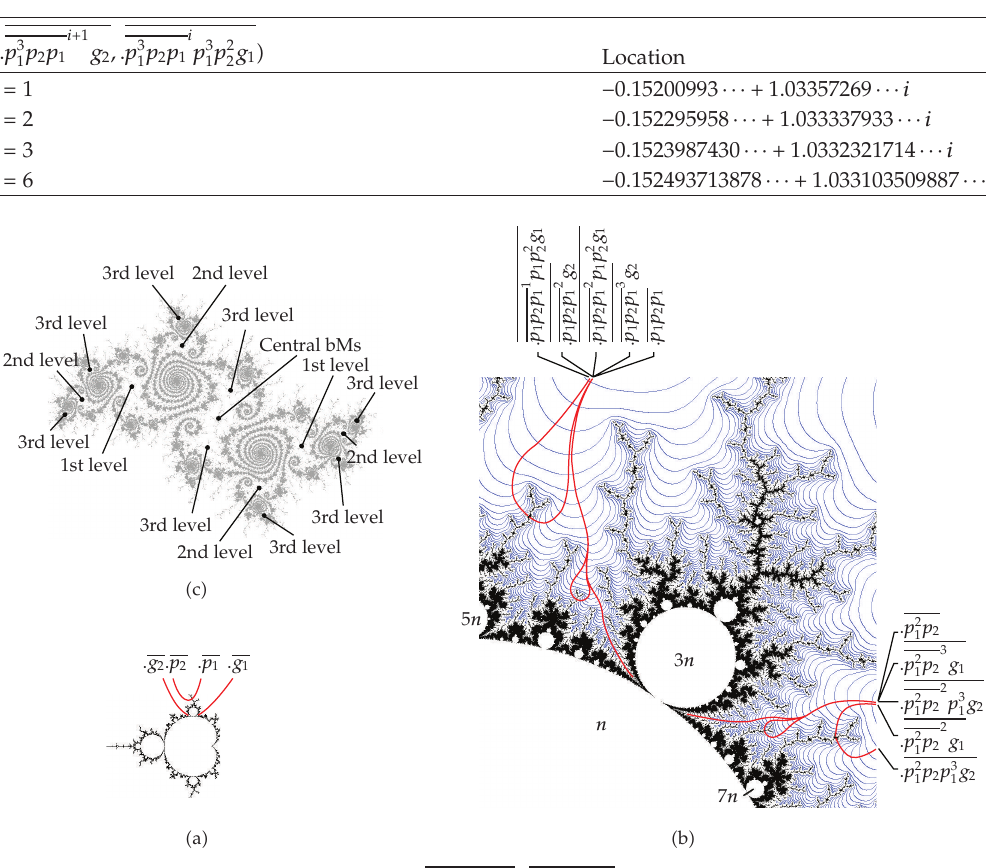
Figure 9: Canonical triple-spiral medallions (cid:4) .p 2 gene. (cid:4) b (cid:5) Graphical location of the medallions i (cid:3) 1 and 2. (cid:4) c (cid:5) Detail of the medallion i (cid:3) 11 where the BMSs up to third level are pointed